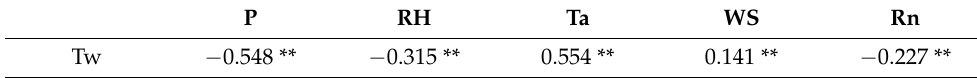
Table 2. Correlation between water surface temperature and meteorological factors.